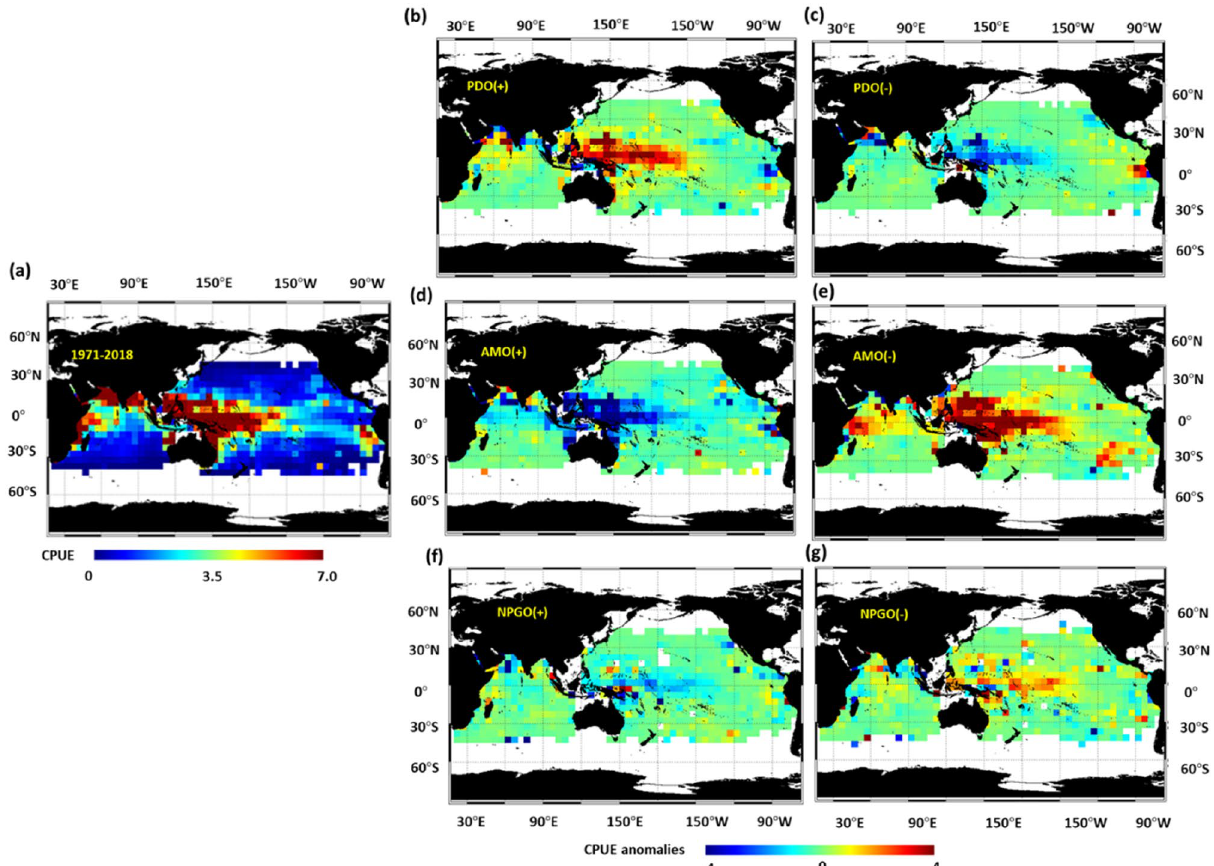
Figure 2. Yellowfin tuna spatial distributions. Distributions of yellowfin tuna CPUE anomalies from ( a ) 1971–2018 and positive ( b ) PDO, ( d ) AMO, and ( f ) NPGO phase years. Distributions from negative ( c ) PDO, ( e ) AMO, and ( g ) NPGO phase years. Figure created with Interactive Data Visualization Solution (IDL v 8.7) software. Software Resource: https:// www. l3har risge ospat ial. com/ Softw are- Techn ology/ IDL.